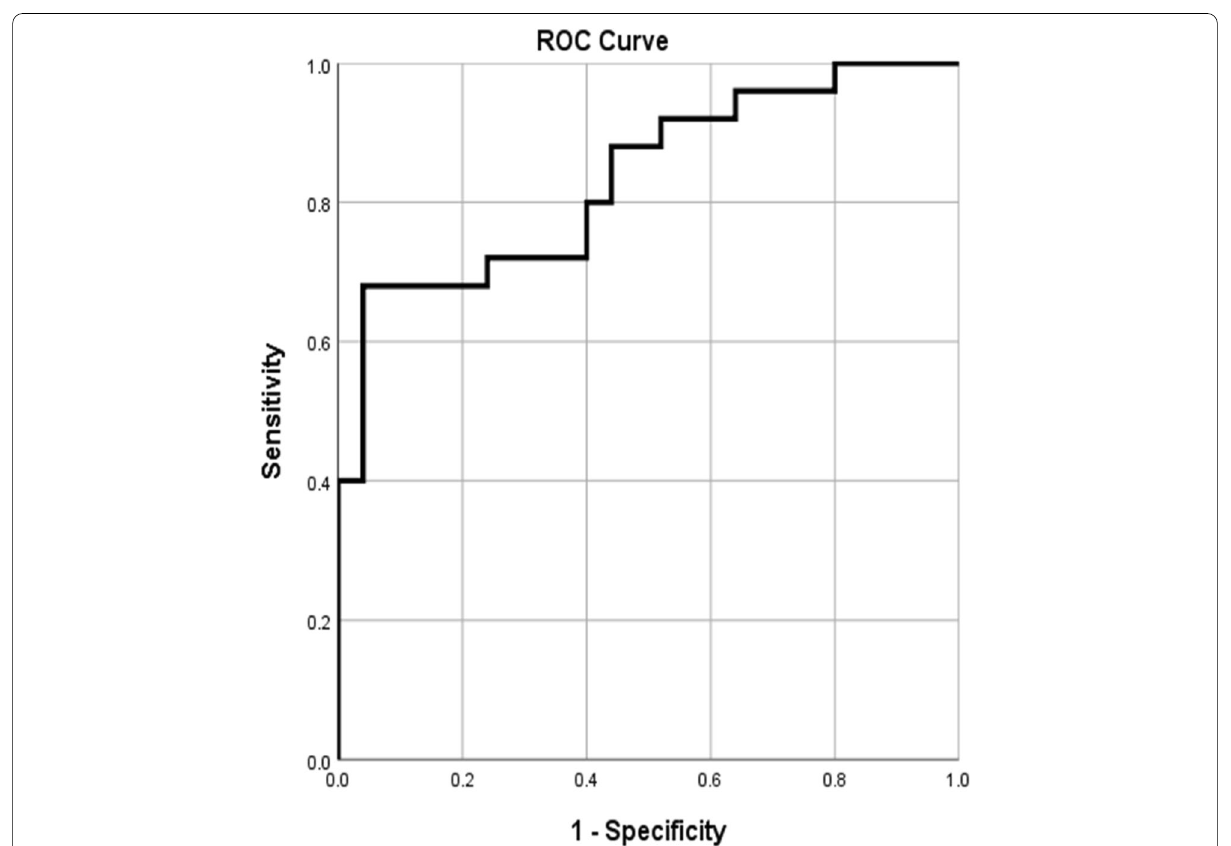
Fig. 1 ROC curve for detection of HCC from liver cirrhosis using miRNA